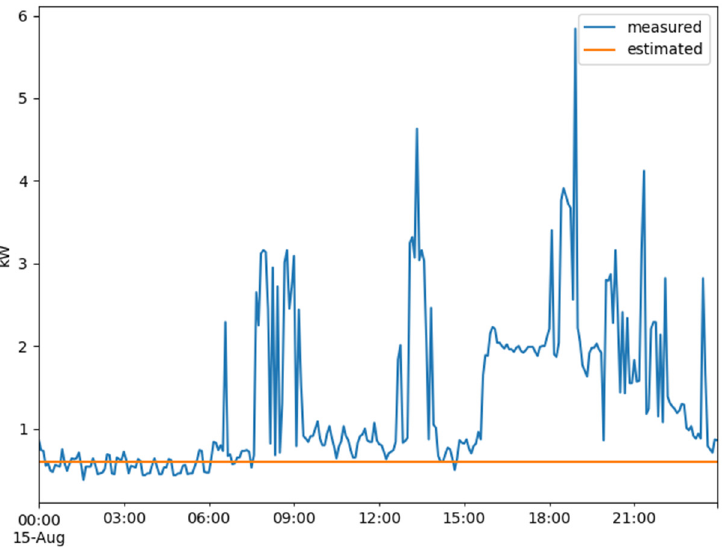
Figure 18. Fifteen-minute measurements on a summer day vs. linear estimated power value for